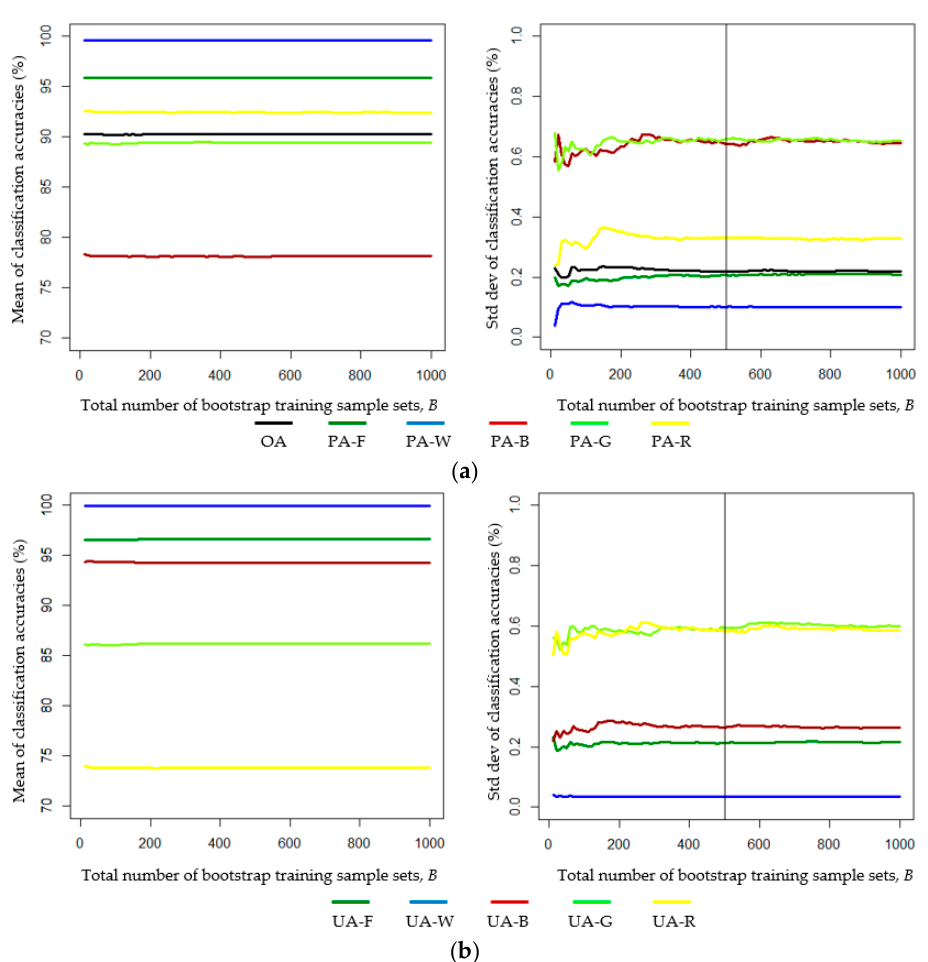
Figure 8. Means and standard deviations of the classification accuracy values derived from multiple sets of bootstrap training samples and their corresponding confusion matrices: ( a ) Overall accuracy (OA) and producer’s accuracy (PA); and ( b ) User’s accuracy (UA). Note: The letters F, W, B, G, and R represent forest, water, buildings, grass, and roads, respectively.